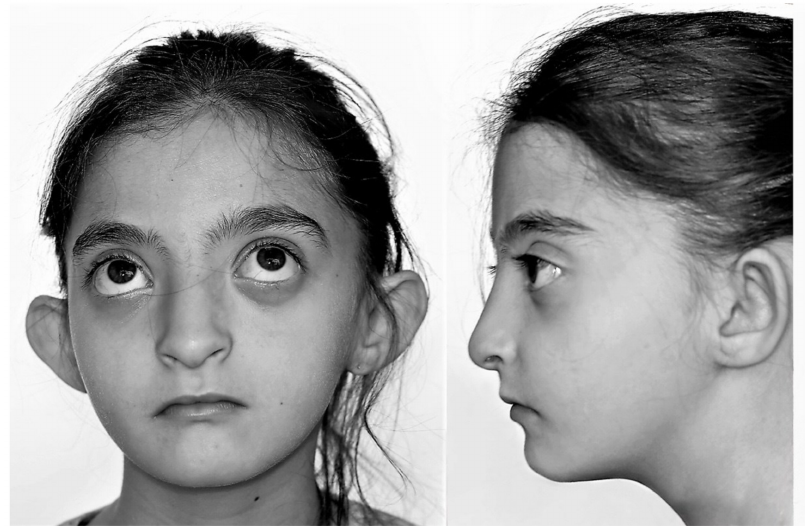
Figure 1. Wolf-Hirschhorn syndrome with characteristic “Greek warrior helmet” facial